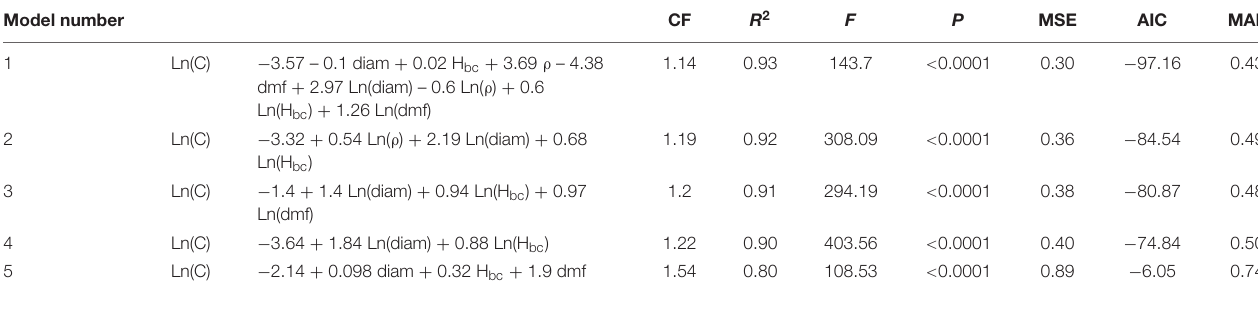
TABLE 2 | General allometric models to estimate total carbon content (C; kg) based on seven species of neotropical palms. Model